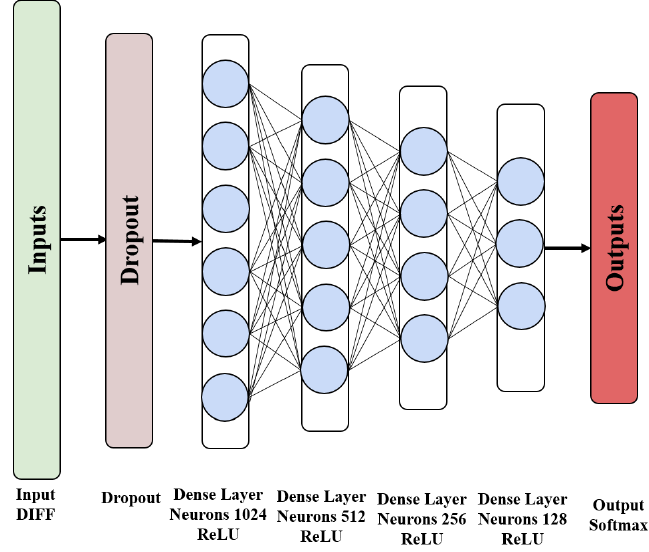
Figure 4. DNN classification